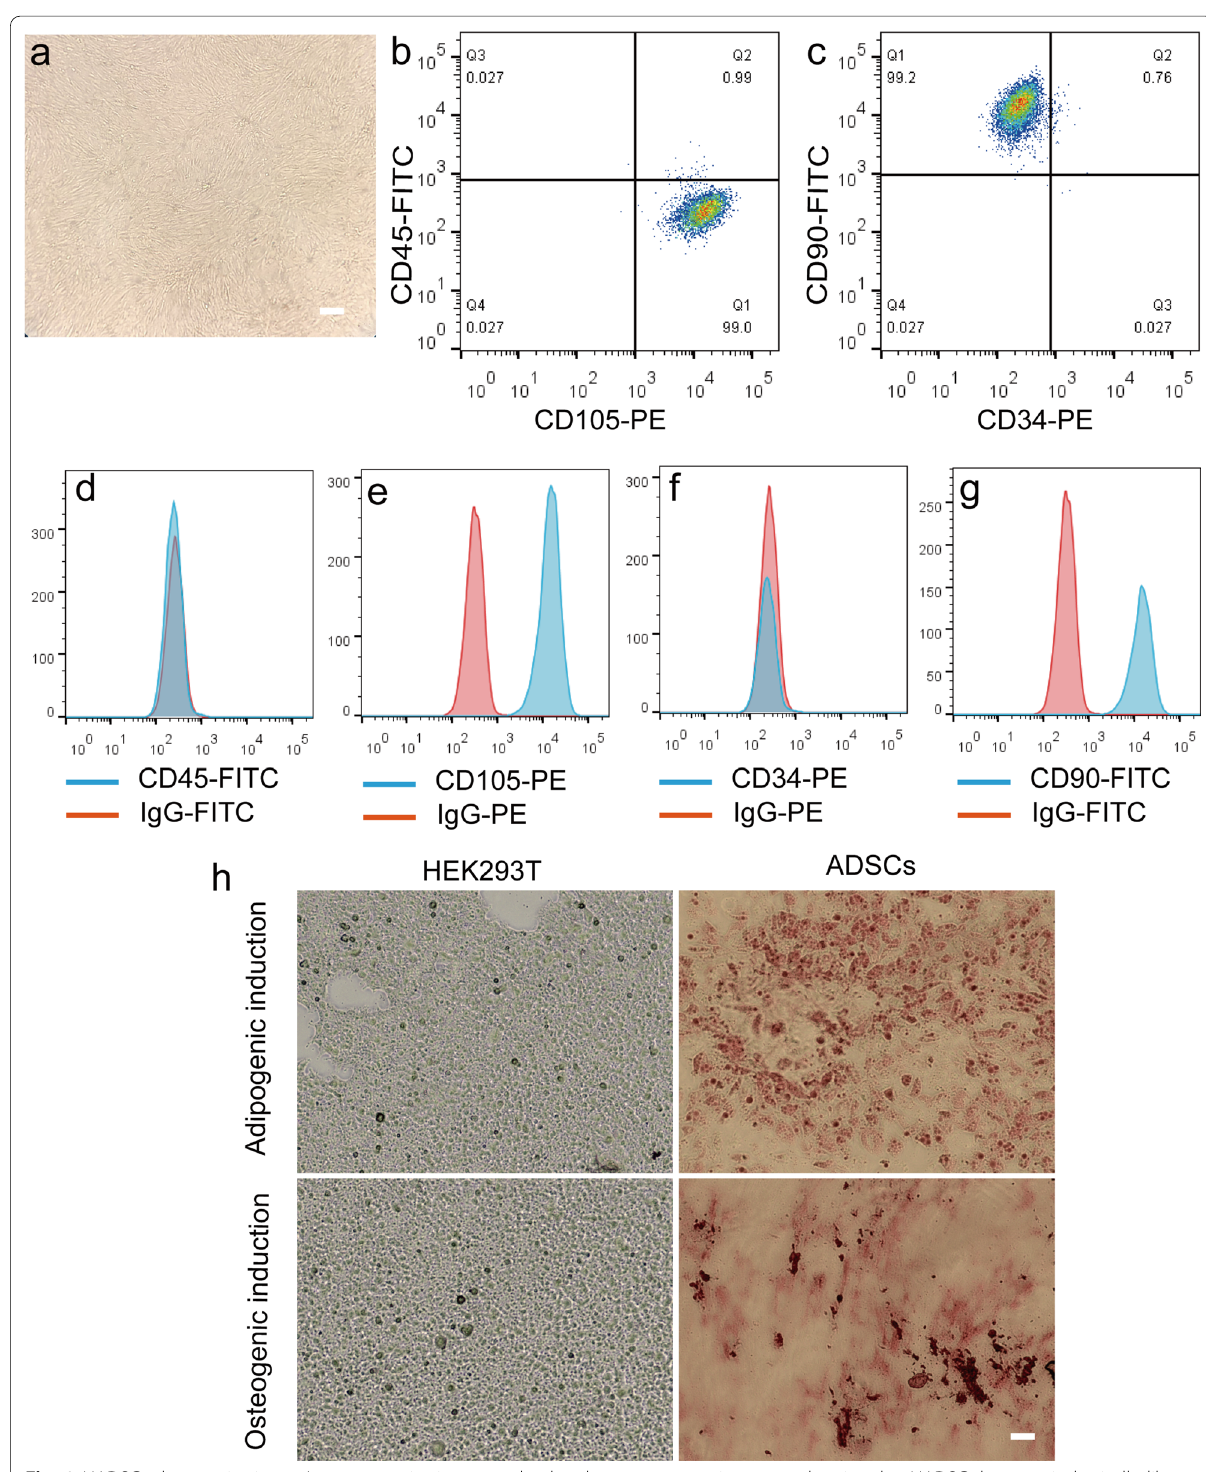
Fig. 6 HADSCs characterization. a A representative image under the phrase contrast microscope showing that HADSCs has a typical spindle-like phenotype. b–g HADSCs were incubated with antibodies conjugating with different dyes against CD45, CD105, CD34 and CD90 markers and subjected to flow cytometric analysis. The scatter diagrams are shown in b, c , and the histograms are shown in d–g . Note that most of the cells were expressed CD90 and CD105, but not CD34 and CD45. h Adipogenic differentiation and osteogenic differentiation of HADSCs versus HEK293 cells are evaluated by Oil Red O or Alizarin Red Staining, respectively. The bar represents 20